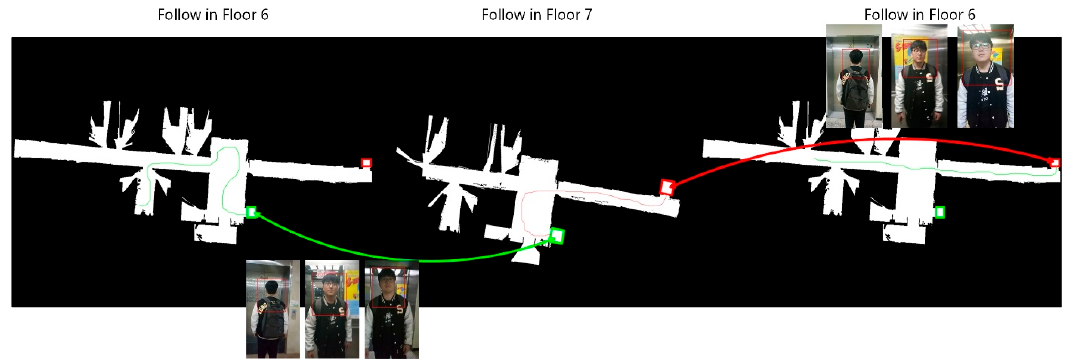
Figure 10. Path during a multi-floor following experiment.